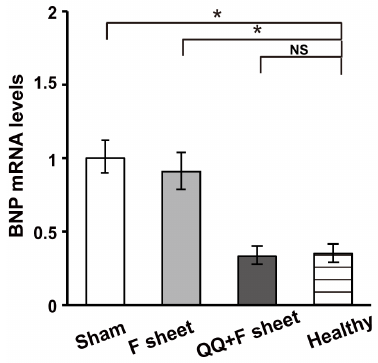
Figure 7. The levels of Bnp gene expression in the heart at 14 days after transplantation of QQ+F sheets derived from EAM rats. Bnp mRNA levels, as measured by qRT-PCR, were significantly higher in the sham and F-sheet groups than in the healthy control group. There was no significant differences between the QQ+F sheet and healthy control groups. N = 5 rats per group. Data are shown as mean ± SE. * p < 0.05, vs. healthy control group. NS, not significant. Bnp , brain natriuretic peptide.